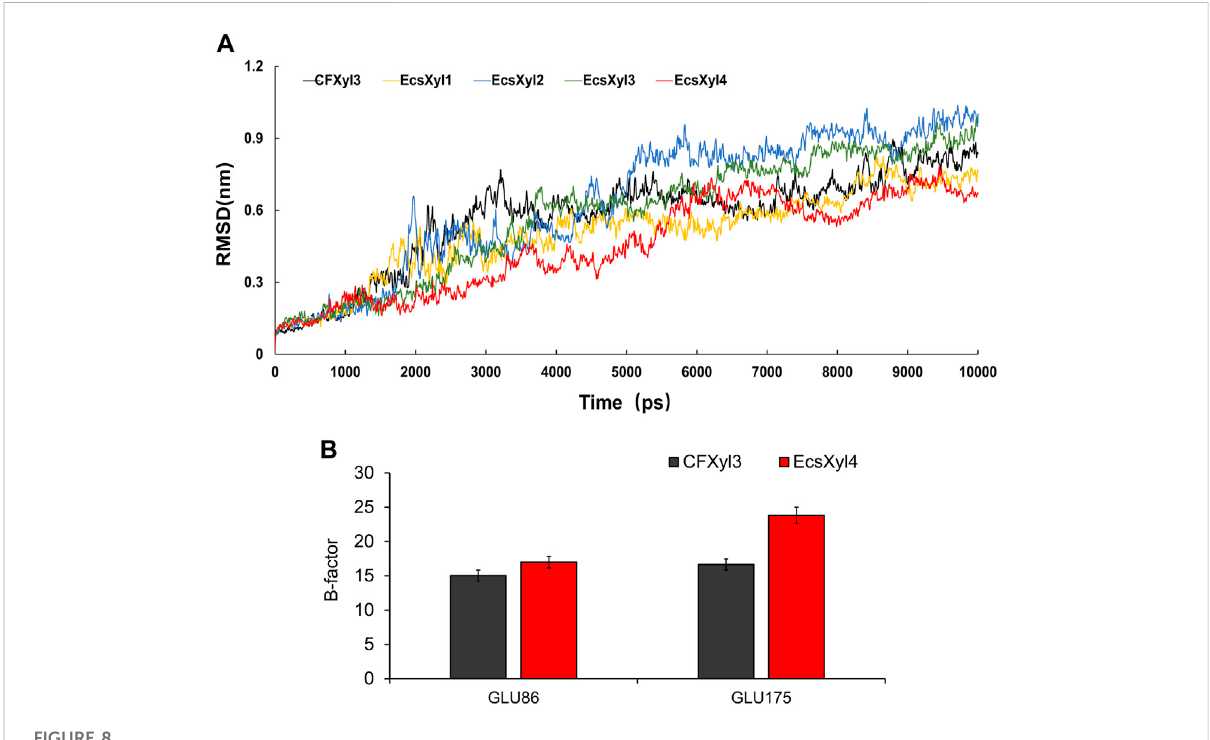
FIGURE 8 Curves of RMSD values of CFXyl3 and EcsXyl1-4 after MD simulations for 10 ns (A) . RMSF values of CFXyl3 and EcsXyl4 at two key catalytic sites (B) .